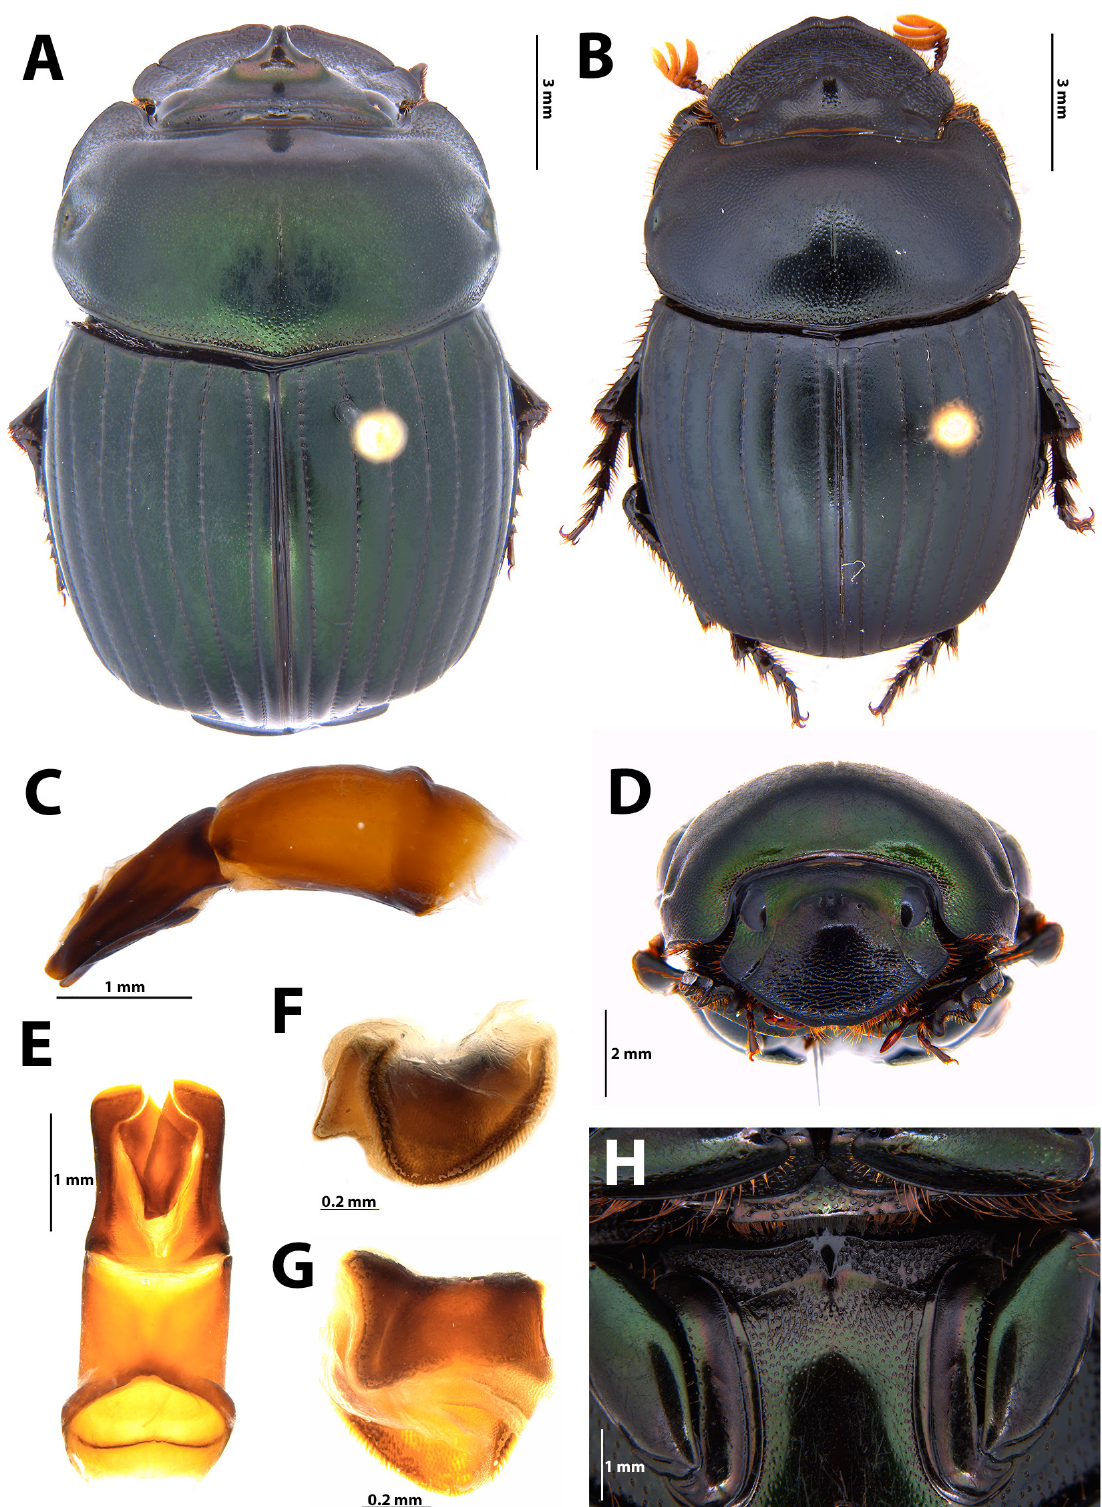
Fig. 12. Dichotomius rafanunezi sp. nov. A–B . Dorsal habitus. A . Holotype, ♂ (CEMT). B . ♀. C . Lateral view of the aedeagus. D . Frontal view of the head. E . Dorsal view of the aedeagus. F–G . Lamella copulatrix. H. Ventral view of the metasternum; antero-medial edge near the interior margin of the mesocoxa